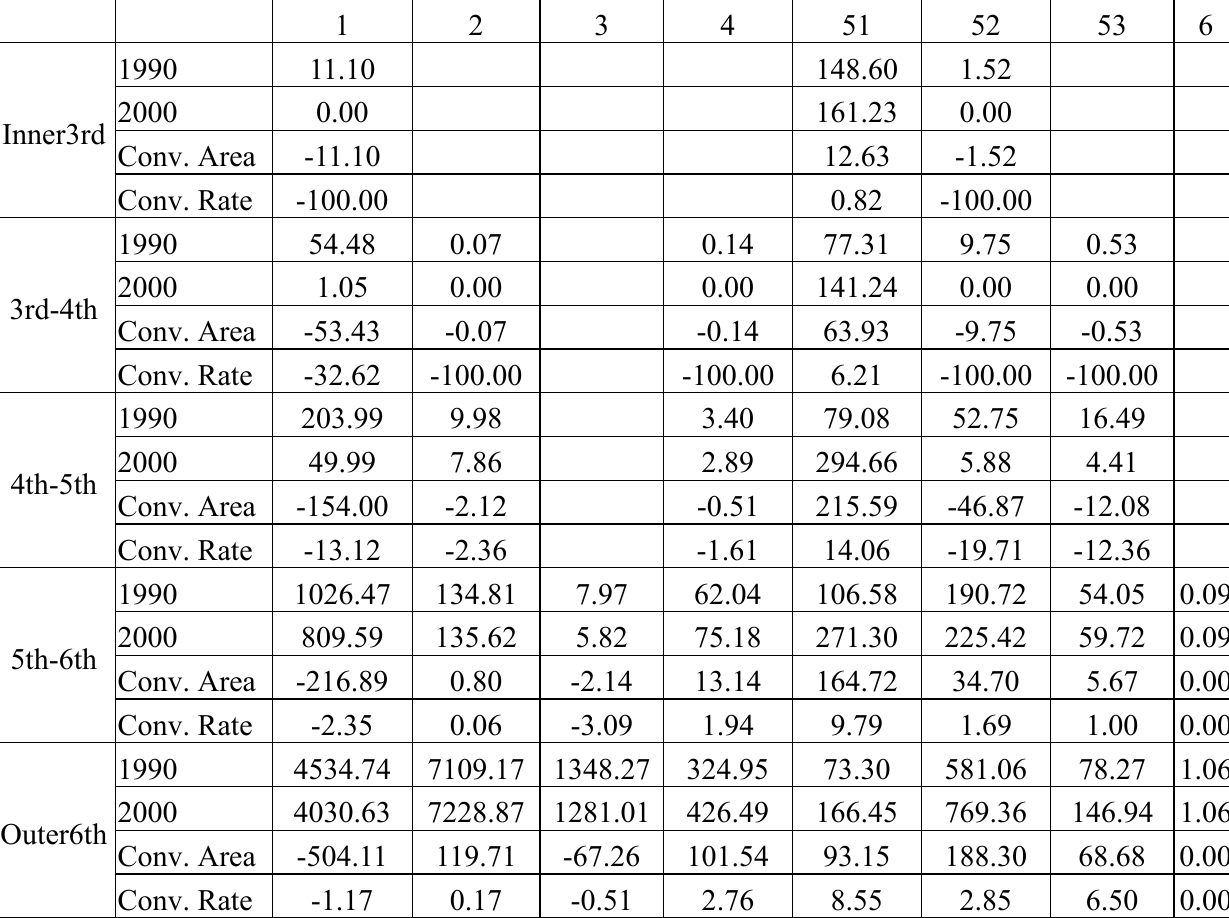
Table 5. Land use changes between major road-rings in Beijing, 1990-2000 (hundred